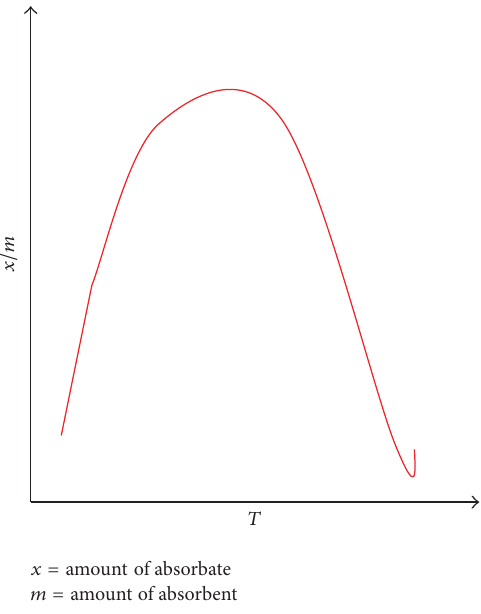
Figure 3: Chemical adsorption versus temperature.